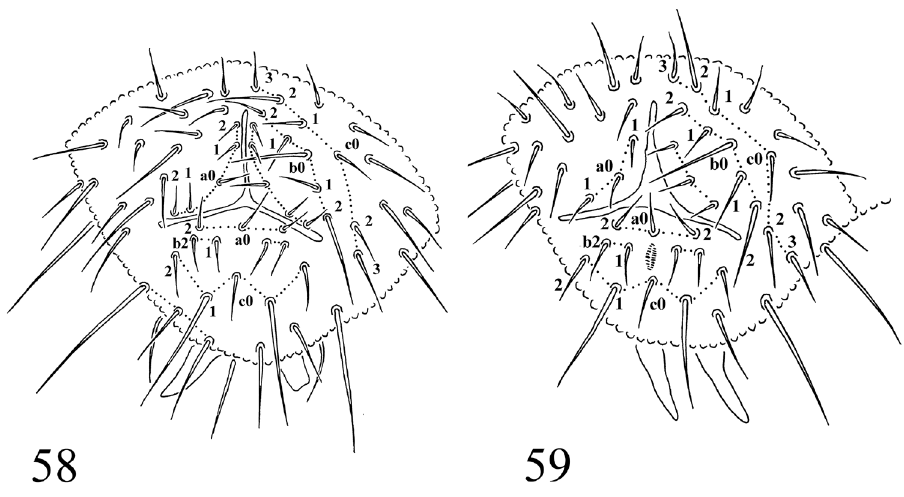
Dorsal chaetotaxy rather symmetrical, as in Fig. 51. Dorsal chaetae well differenti- ated into macrochaetae and microchaetae. Sensory chaetae s indistinct on body. On head p2 chaetae are displaced forward in relation to p1 and p3. Chaetae p6 located be- tween pseudocelli a and b on head. Th. tergum I with 10–11+10–11 chaetae, chaeta m absent (chaetotaxy type i2–3-). Both Th. terga II and III with lateral microsensilla and with 5+5 or 6+6 axial microchaetae. Chaetae s' absent on Abd. terga I–III and present